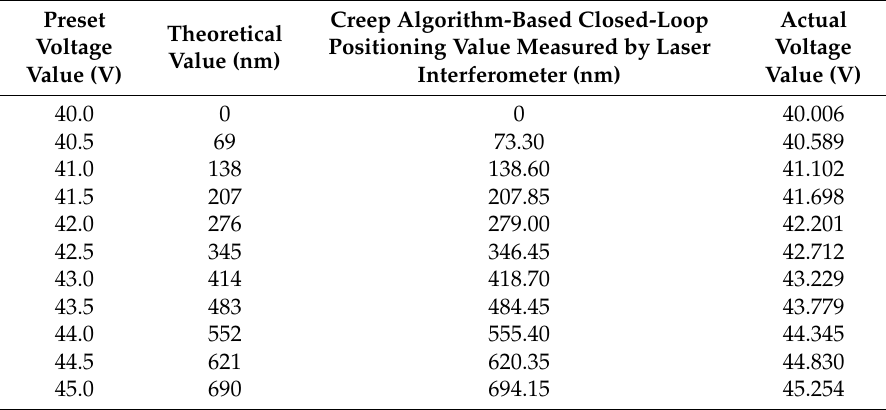
Figure 12. Experimental equipment of the piezoelectric ceramic control system. Table 2. The measured data of the preset